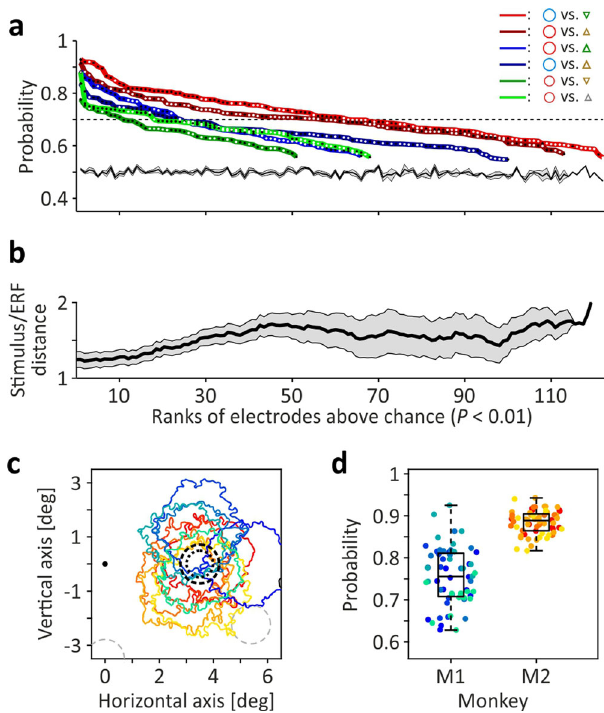
Fig. 7 Single-trial object classi fi cation based on non-spatial features. a Support-vector machine performance at individual electrodes for six different classi fi cation conditions, comparing objects eliciting high vs. low gamma (red lines), high vs. medium gamma (blue lines), and medium vs. low gamma (green lines). Black and white dots plotted on lines indicate individual electrodes of M1 and M2, respectively. Only electrodes with performance signi fi cantly ( P < 0.01) above chance level are shown, ranked by classi fi cation rate. Experimentally determined mean chance level ± SEM is given by black line and gray-shaded area. b Mean center-to-center distance between ERF and closest stimulus of electrodes with signi fi cant classi fi cation performance. Black line indicates moving average over 25 electrodes, shifted by 1 electrode, gray-shaded area indicates corresponding SEM. c ERF outlines of fi ve selected electrodes per monkey (M1: bluish/ greenish, M2: reddish/yellowish). d Single-trial classi fi cation performance of electrodes shown in ( b ) to each of 12 high vs. low gamma conditions. Boxes indicate 25th and 75th percentile including median, whiskers indicate interquartile